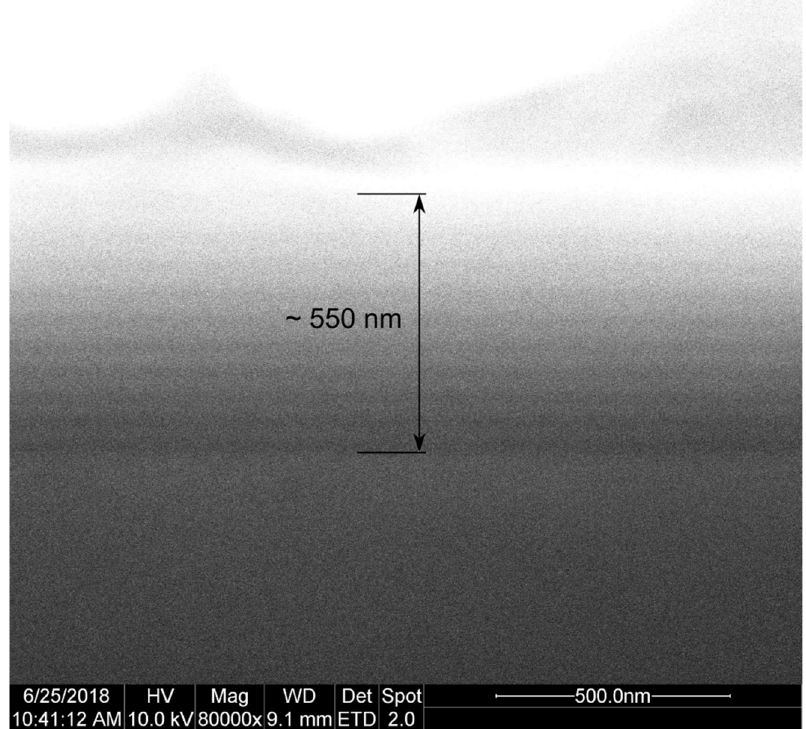
Figure 4. SEM image of superlattice sample (samples #3 and #4).